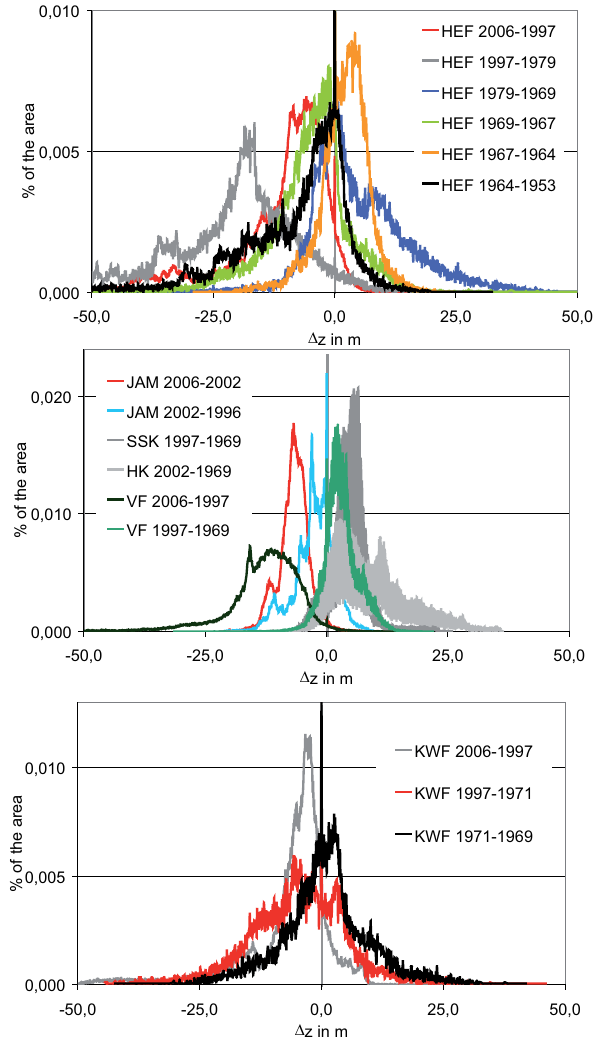
Fig. 11. Relative frequencies of values occurring in the calculated volume differences for the Austrian glaciers.